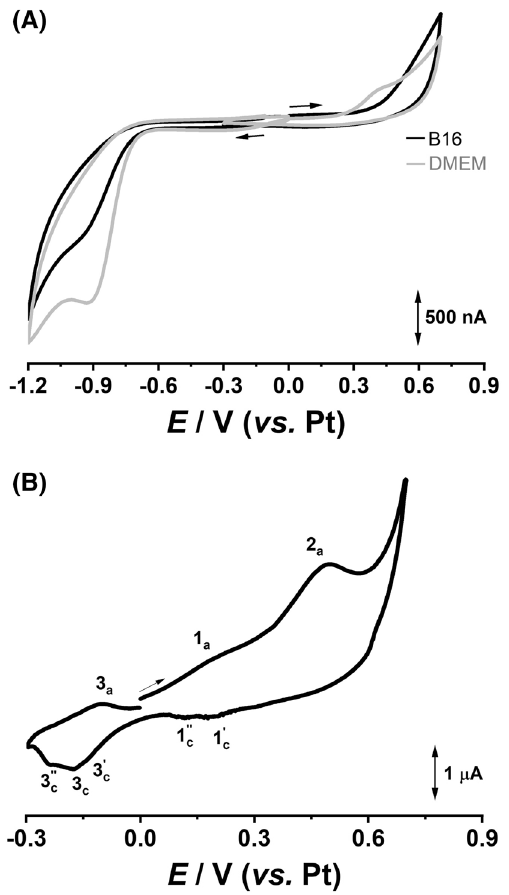
Figure 4. Cyclic voltammograms recorded at gold electrode for (grey line) culture medium and (black line) B16 cells ( A ) before and ( B ) after proton irradiation at a dose of 1